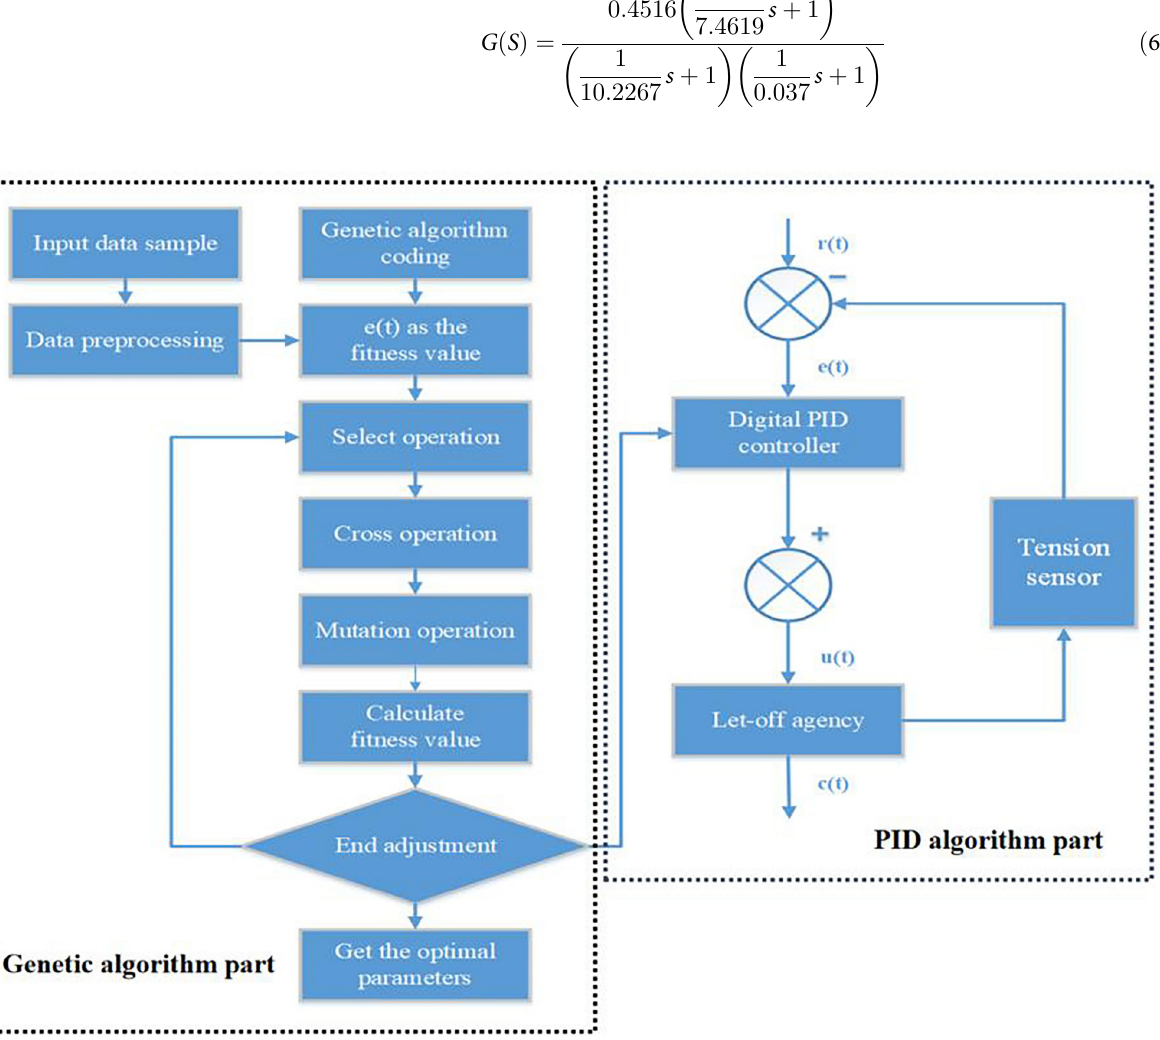
Fig 13. Principle block diagram of PID control algorithm based on genetic